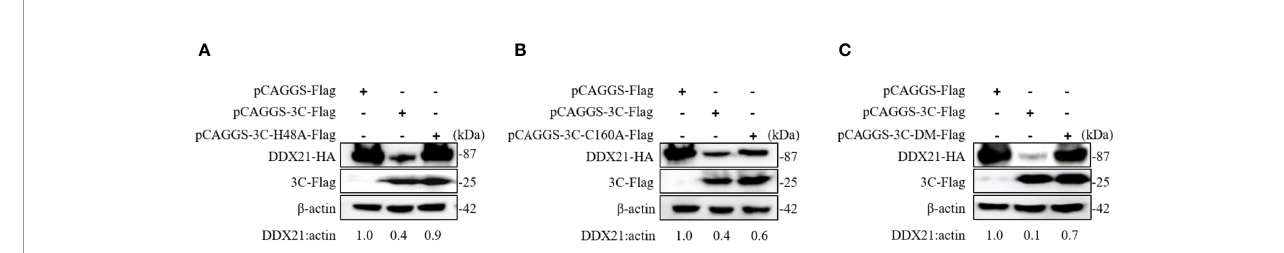
FIGURE 5 | SVA 3C protein targets DDX21 for degradation through its protease activity. (A) HEK293T cells were cotransfected with HA-DDX21 and 3C protein or 3C-H48A for 30 h. The cell lysates were prepared for Western blot analysis using the indicated antibodies. (B) HEK293T cells were cotransfected with HA-DDX21 and 3C protein or 3C-C160A for 30 h. The cell lysates were prepared for Western blot analysis using the indicated antibodies. (C) HEK293T cells were cotransfected with HA-DDX21 and 3C protein or 3C-DM for 30 h. The cell lysates were prepared for Western blot analysis using the